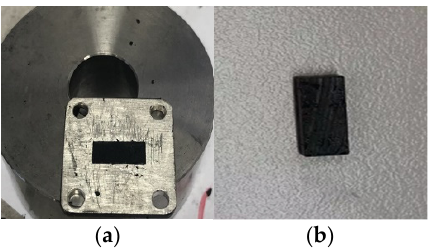
Figure 6. Preparation of mixed material samples. ( a ) Mixed material filled in the groove. ( b ) Rectan- gular sample for measurement.